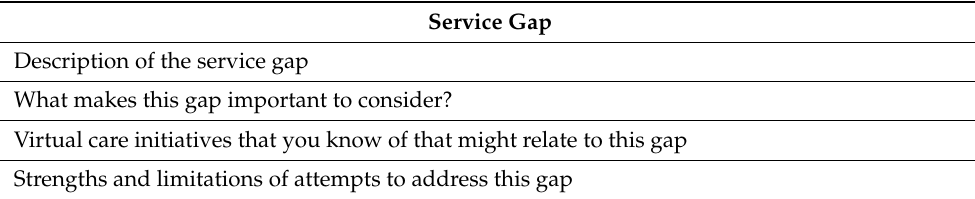
Table A2. Template for providing information for individual virtual care service gaps.